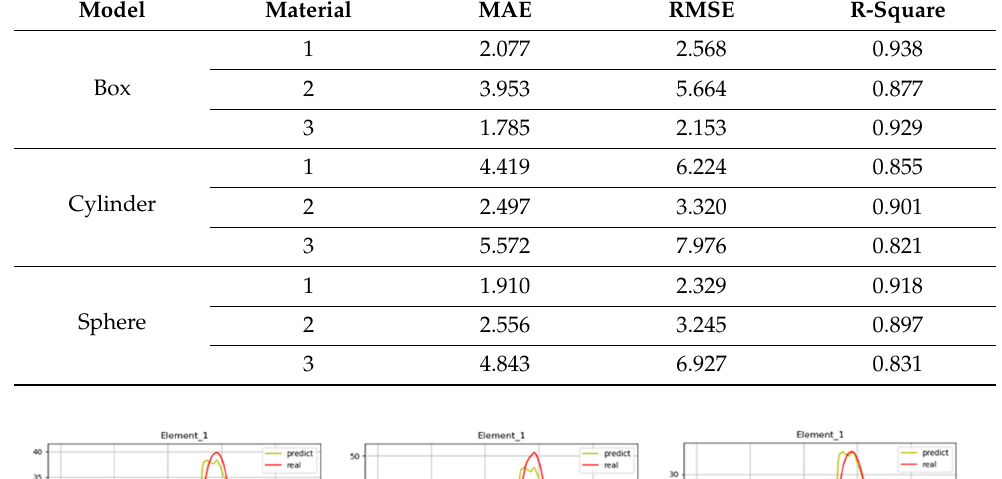
Table 3. MTPHNet’s generalization performance for multi-object temperature field prediction.